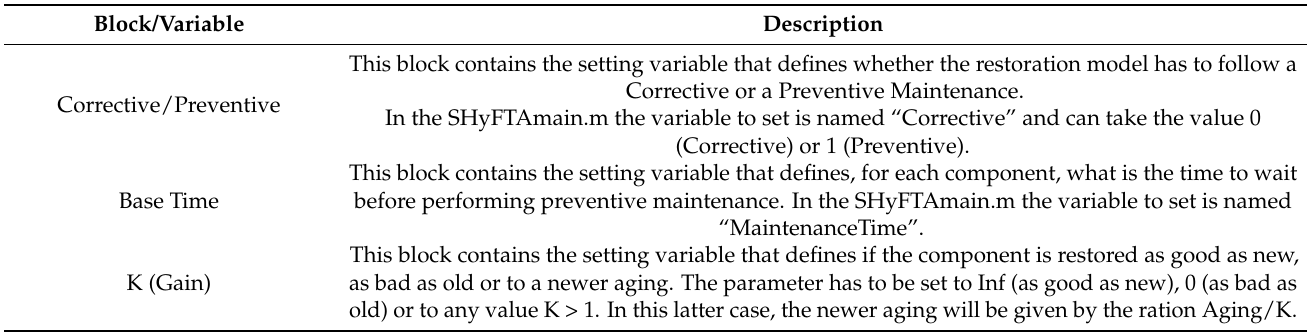
Table 5. Main elements of the Maintenance Box